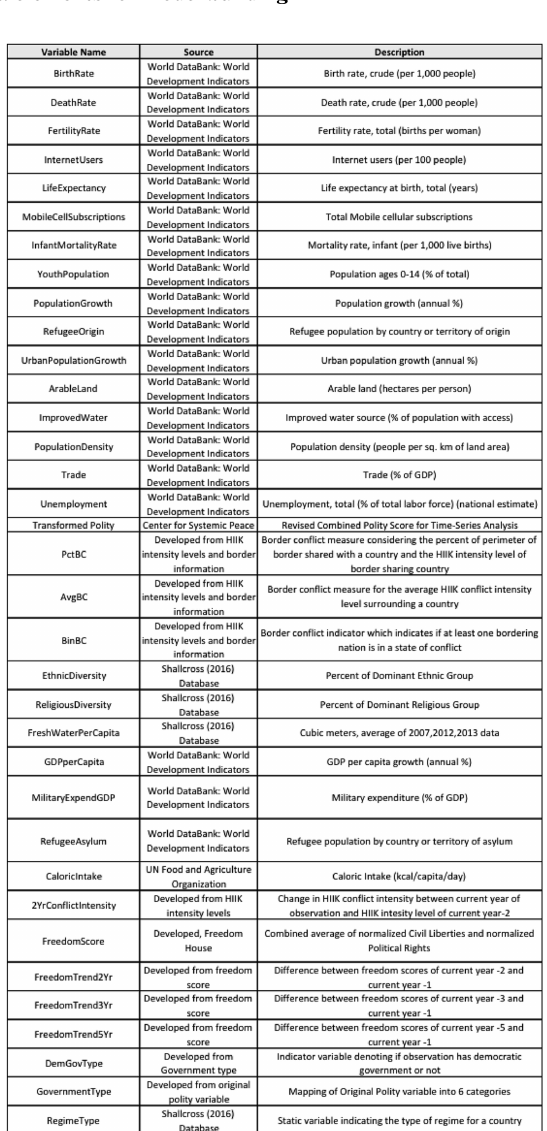
Figure A1. Variables for